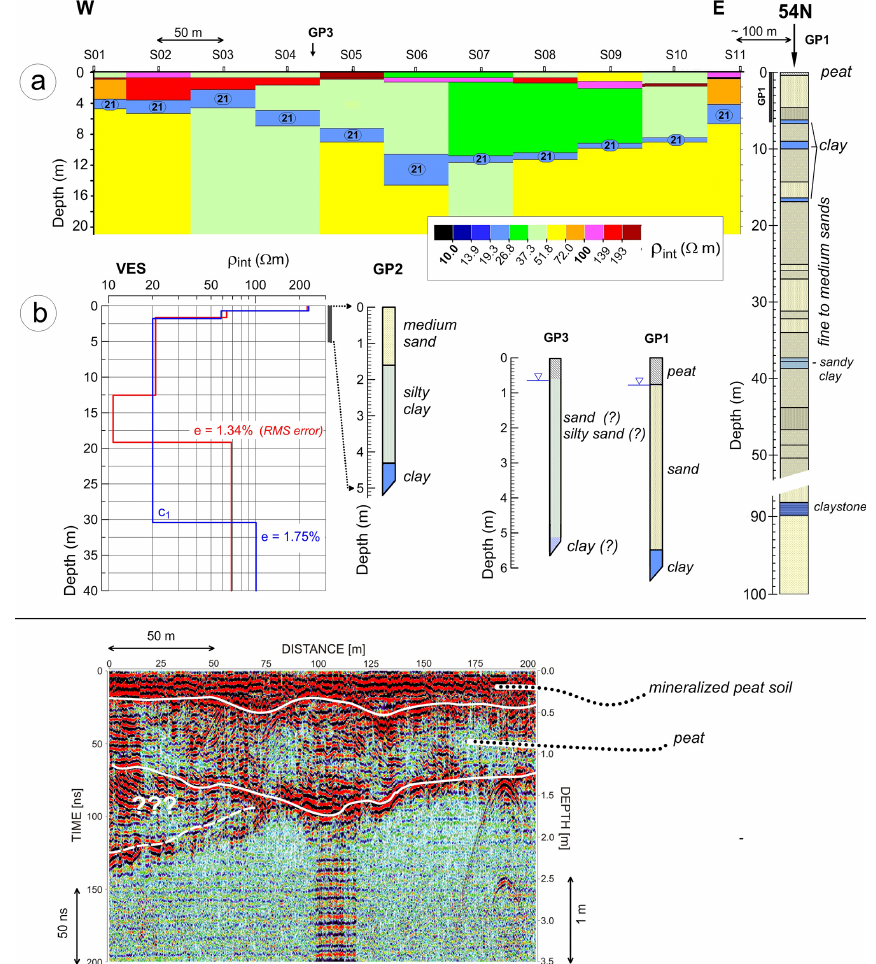
Figure 4. Upper panel: the results of vertical electrical sounding (VES). (a) 1-D interpreted resistivity section (S01–S11). Clay layer marked in blue. (b) Two variants of interpreted resistivity vertical profile based on VES sounding in the vicinity of GP 2 site. C1 corresponds to fixed resistivity of clay equal to 21Ohmm. Also shown are the geological logs of Geoprobe ® soil cores at GP1, GP2 and GP3 and the borehole drilled in the centre of the Wielkie Błoto fen (54N). Lower panel: GPR echogram along the P1 profile shown in Fig. 2 (see text for